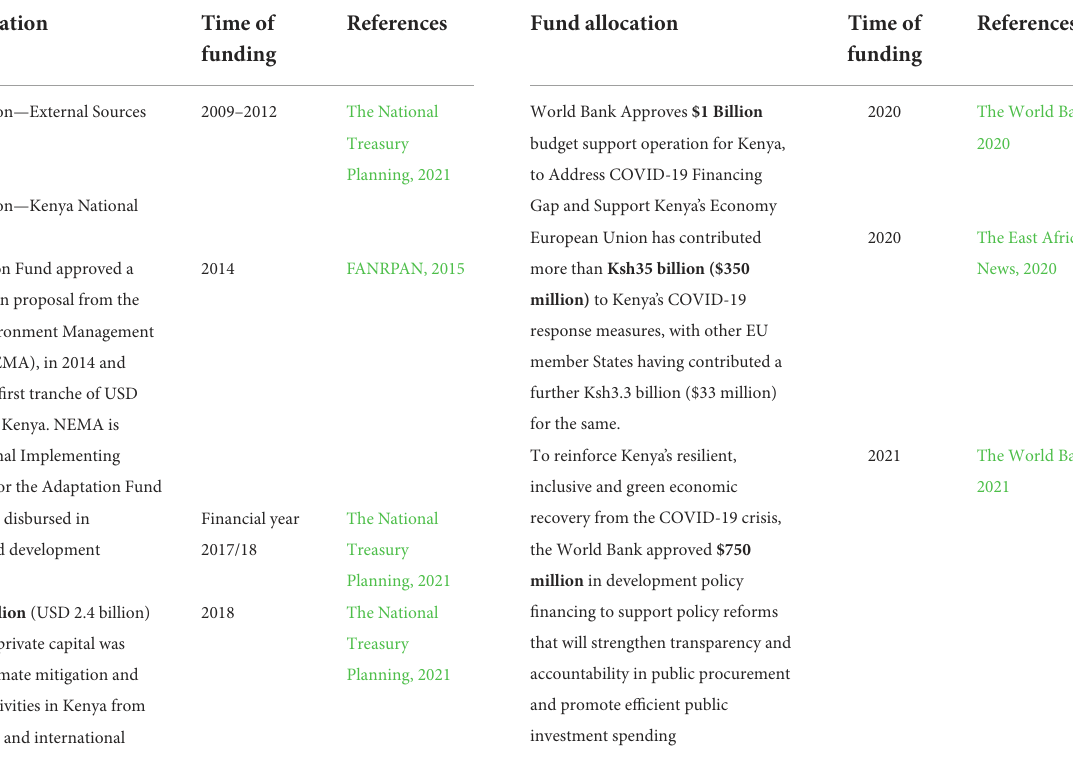
TABLE 1 The landscape of climate financing in Kenya. TABLE 2 The landscape of Covid-19 Financing in